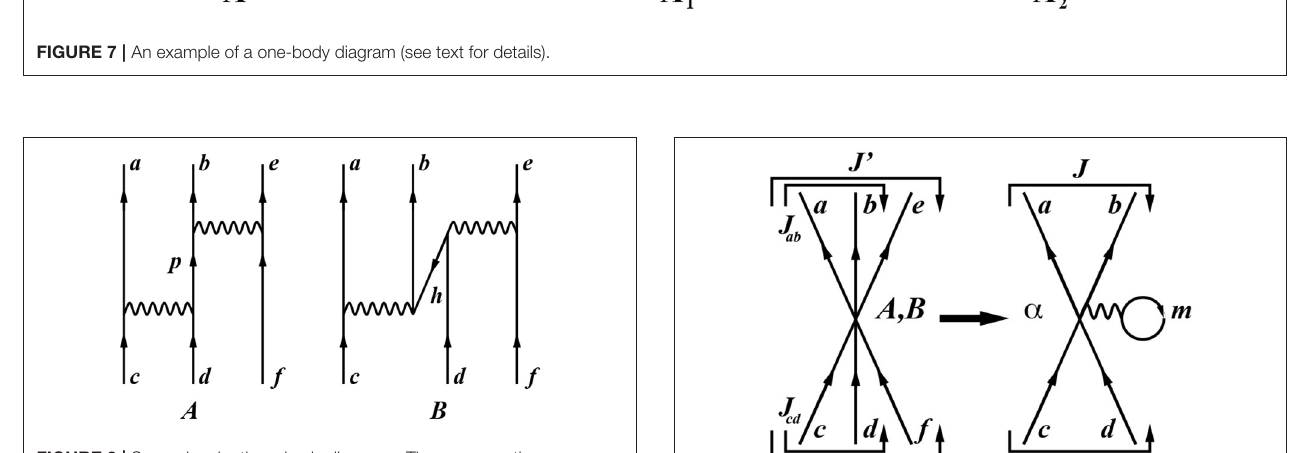
FIGURE 8 | Second-order three-body diagrams. The sum over the intermediate lines runs over particle and hole states outside the model space, shown in A and B , respectively. For the sake of simplicity, for each topology we show only one of the diagrams which correspond to permutations of the external lines.